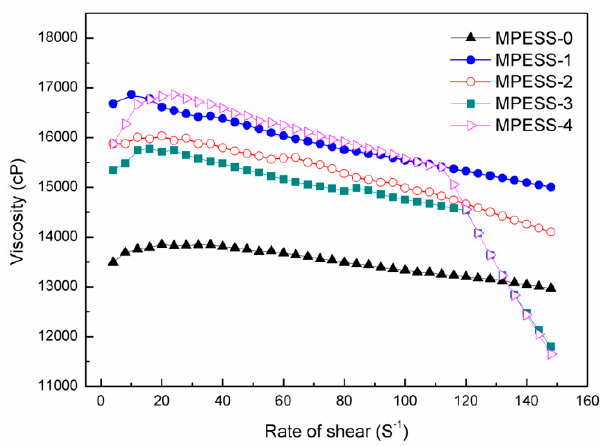
Figure 2. Shear viscosities of the PES/SPES/DMAc/PEG200 casting solutions.